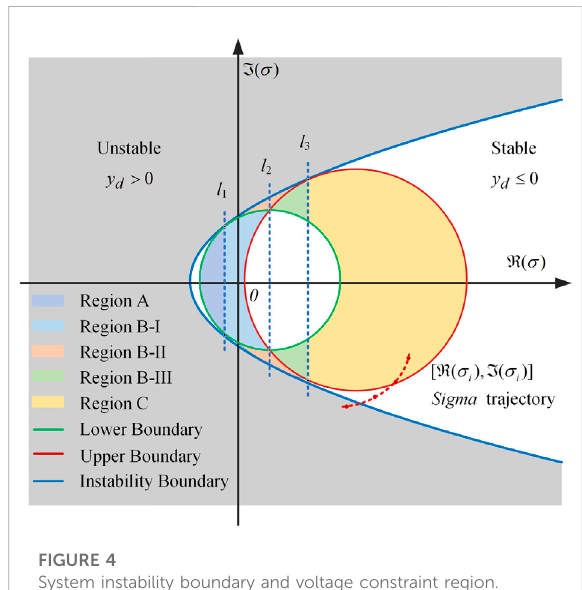
FIGURE 4 System instability boundary and voltage constraint